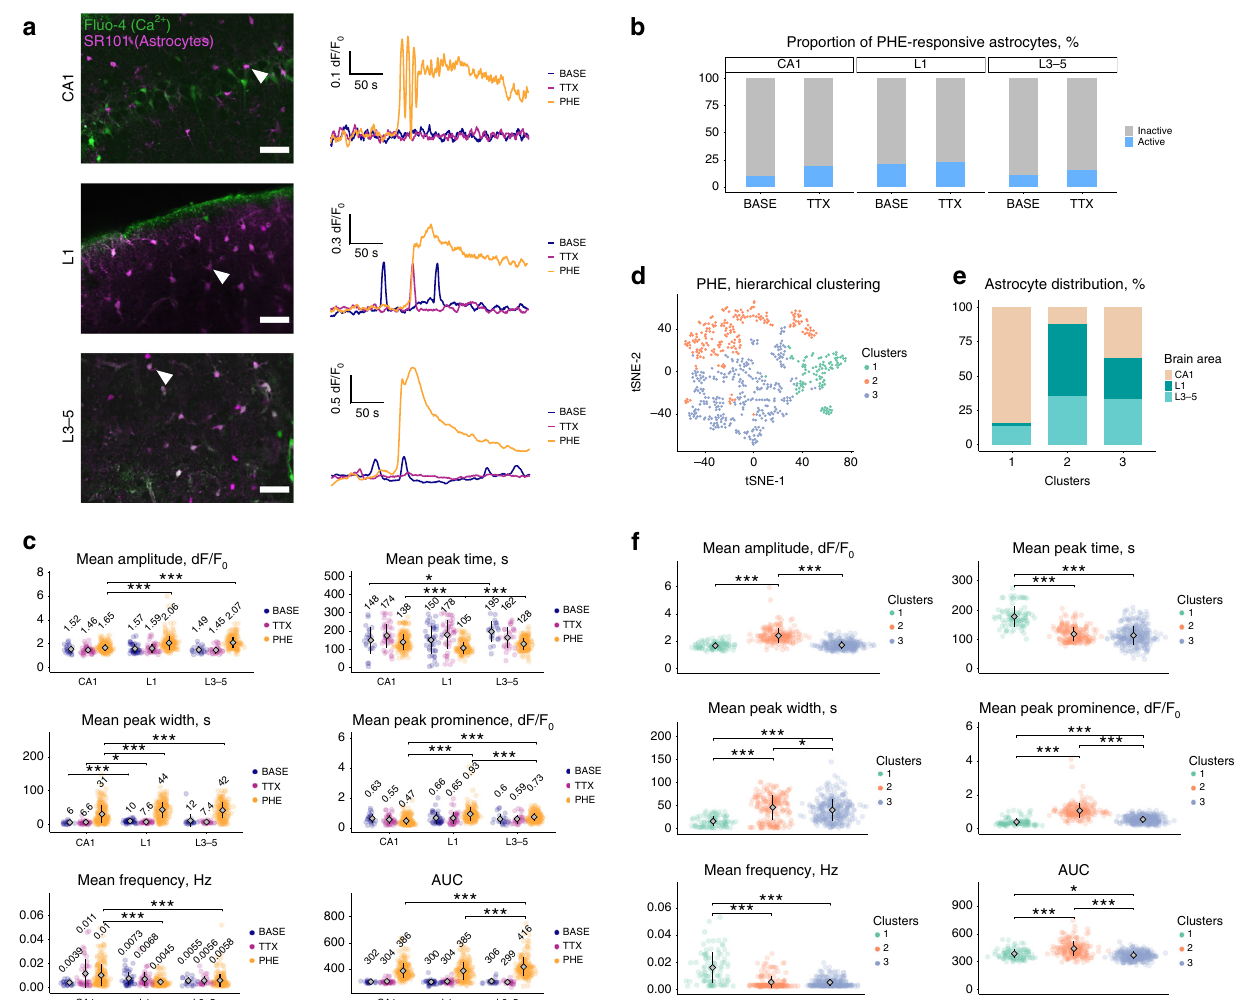
Fig. 8 Astrocyte subpopulations display distinct Ca 2 + transient properties. Calcium transients in SR101-labeled astrocytes were detected using Fluo-4. Measurements were made in acute brain slices containing cortical layer 1 (L1), cortical layers 3 – 5 (L3 – 5), and the CA1 region of the hippocampus (CA1). Transients were recorded under sequential conditions of baseline activity (BASE), tetrodotoxin (TTX), and TTX plus phenylephrine (PHE). a Representative astrocytes (arrowheads) and the calcium transients recorded from them under each experimental condition. Scale bar, 50 µ m. b The total population of active astrocytes was de fi ned as cells responding to application of PHE. The fraction of this population displaying Ca 2 + transients under BASE and TTX conditions is shown in blue. c Transient parameters grouped by the brain region recorded. Numerical values are the means for each condition. d Hierarchical clustering of Ca 2 + transient parameters after application of PHE. e Proportion of astrocytes from the various brain regions per cluster de fi ned in d . f Astrocyte peak parameters grouped per cluster. One dot equals one cell in c , d , and f . Plots in c and f show mean ± SD. Data normality was tested using a Shapiro – Wilk test. Signi fi cant differences were veri fi ed using a Kruskal – Wallis test with post-hoc Dunn ’ s test, with p -values adjusted with